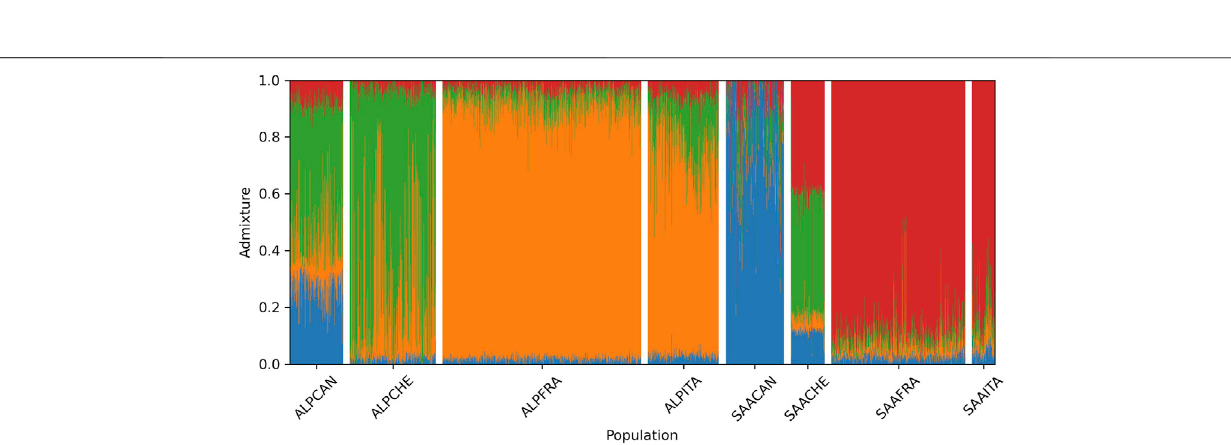
0.02 for French, and 0.04 for Italian animals. This blue cluster is also strongly represented (0.30) in the Canadian Alpine population. Another ancestral cluster (green color in Figure 5 ) also seems to be widely shared between Swiss Alpine (0.69), Canadian Alpine (0.46), and Swiss Saanen (0.41).